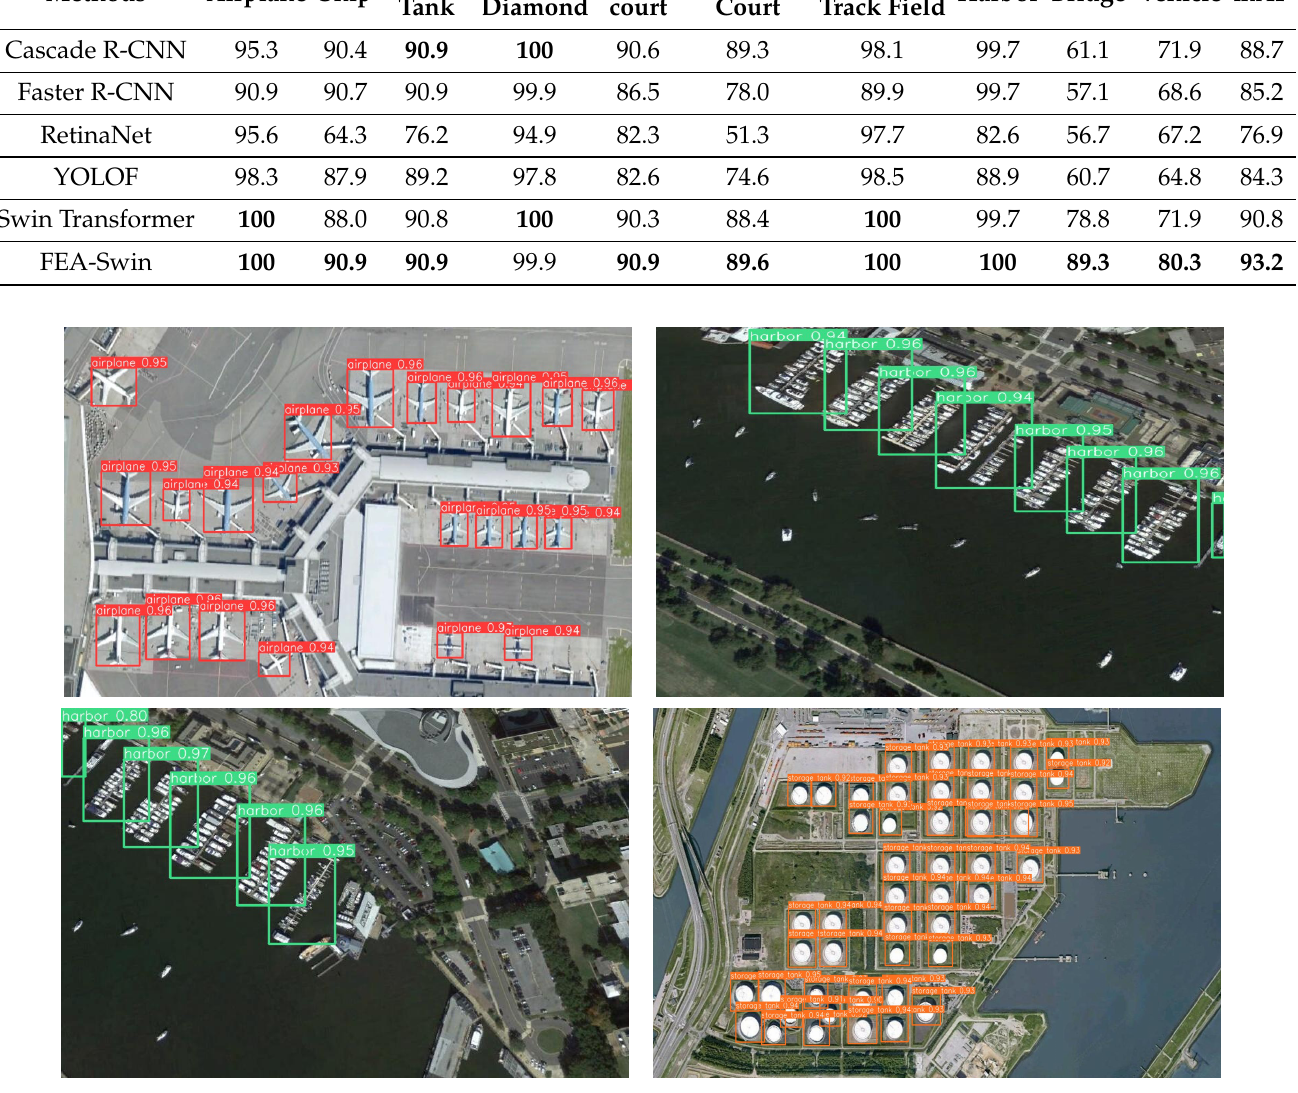
Figure 11. Some examples of detection results on the NWPU VHR-10 dataset using